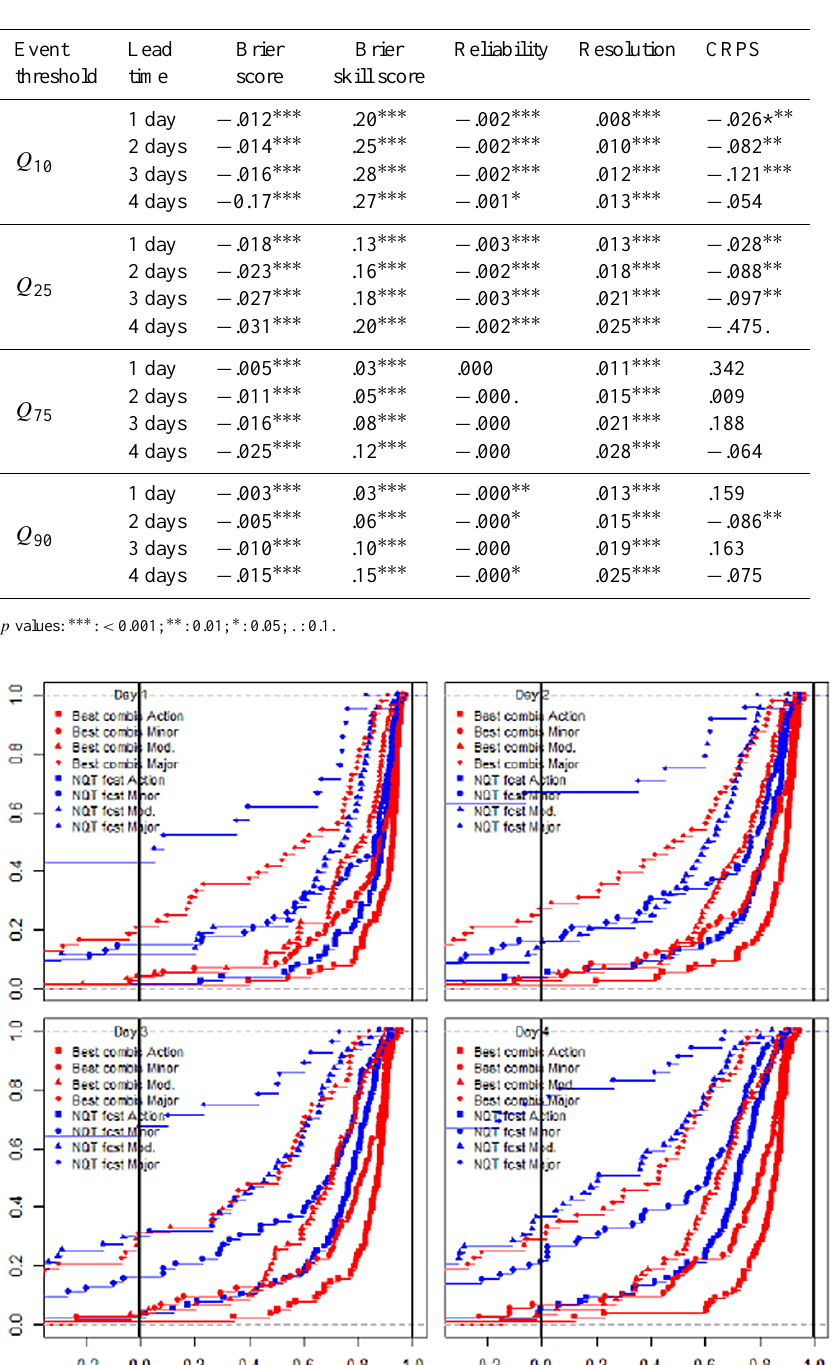
Table 4. Results of paired t tests comparing the QR method’s performance with only forecast as predictor and the best-performing combina- tion of five predictors for each river gauge for the Brier score.